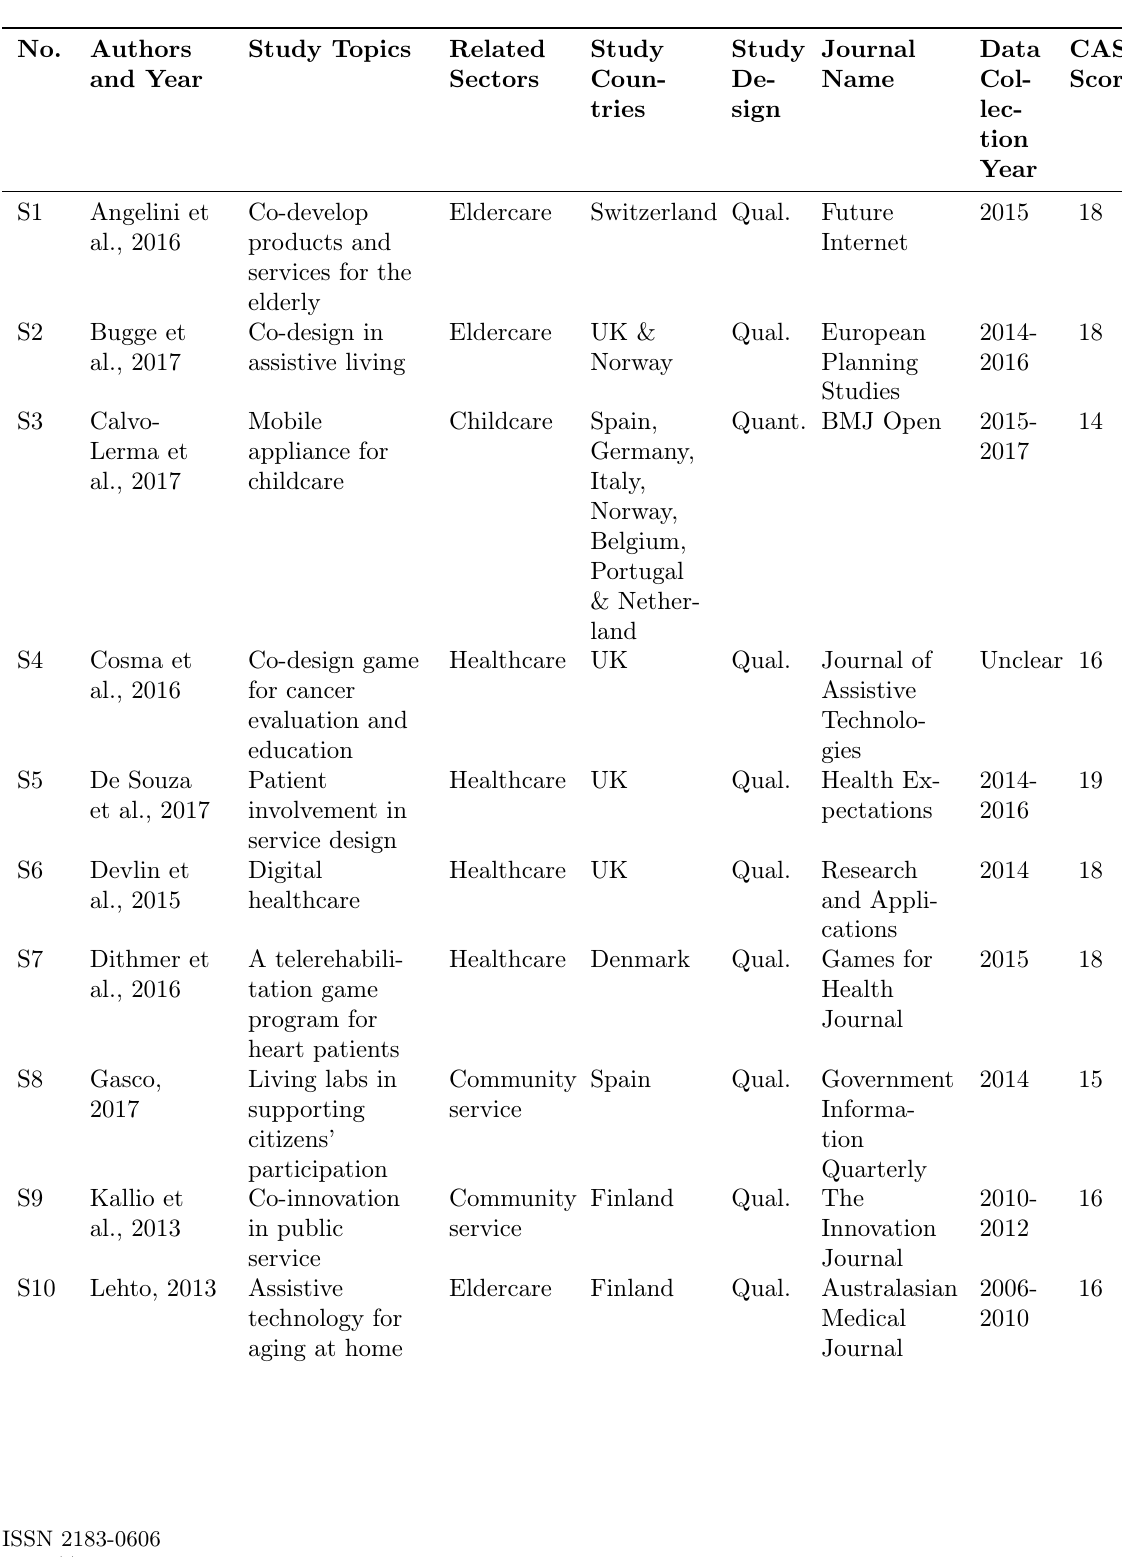
Table 2. Basic Publish Characteristics of Selected Studies